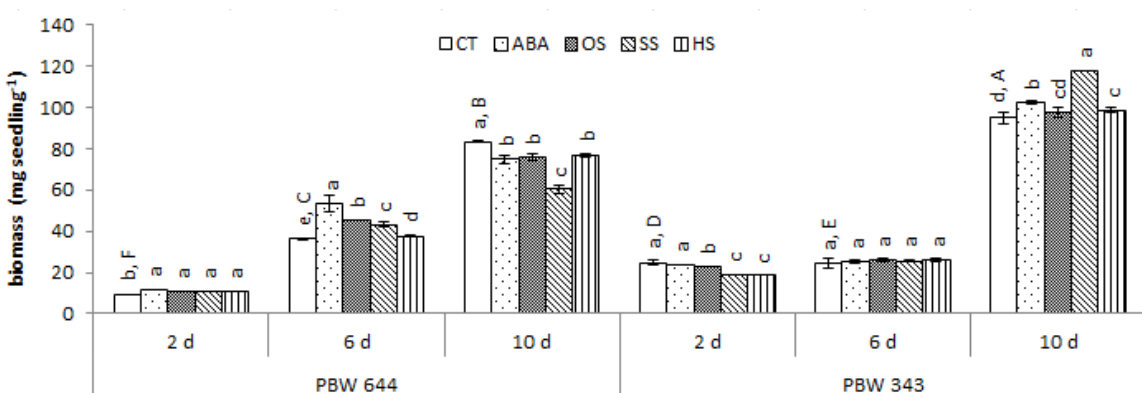
Figure 1 - Change of biomass during post-germination desiccation and subsequent rehydration in wheat cultivars PBW 644 and PBW 343 where 1 d old seedlings were exposed to ABA, osmotic stress (OS), salt stress (SS), heat stress (HS) for next 1 d, then desiccated for 4 d subsequently rehydrated for next 4 d. Data was taken at 2 d (before desiccation), 6 d (desiccated) and 10 d (rehydrated) stages. Different uppercase alphabets represent significant difference among all six CT values (three stages of both cultivars) and different lowercase alphabets represent significant difference among treatments and CT at each stage (Duncan Multiple test p ≤